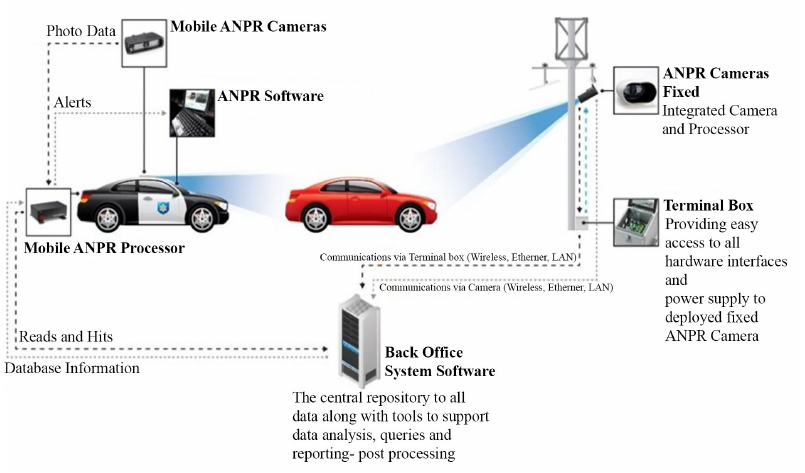
Figure 1. Typical ANPR System Diagram of a Fixed ANPR System ( right ) and a Mobile ANPR System ( left ) (Source: latech.us, accessed on 5 November